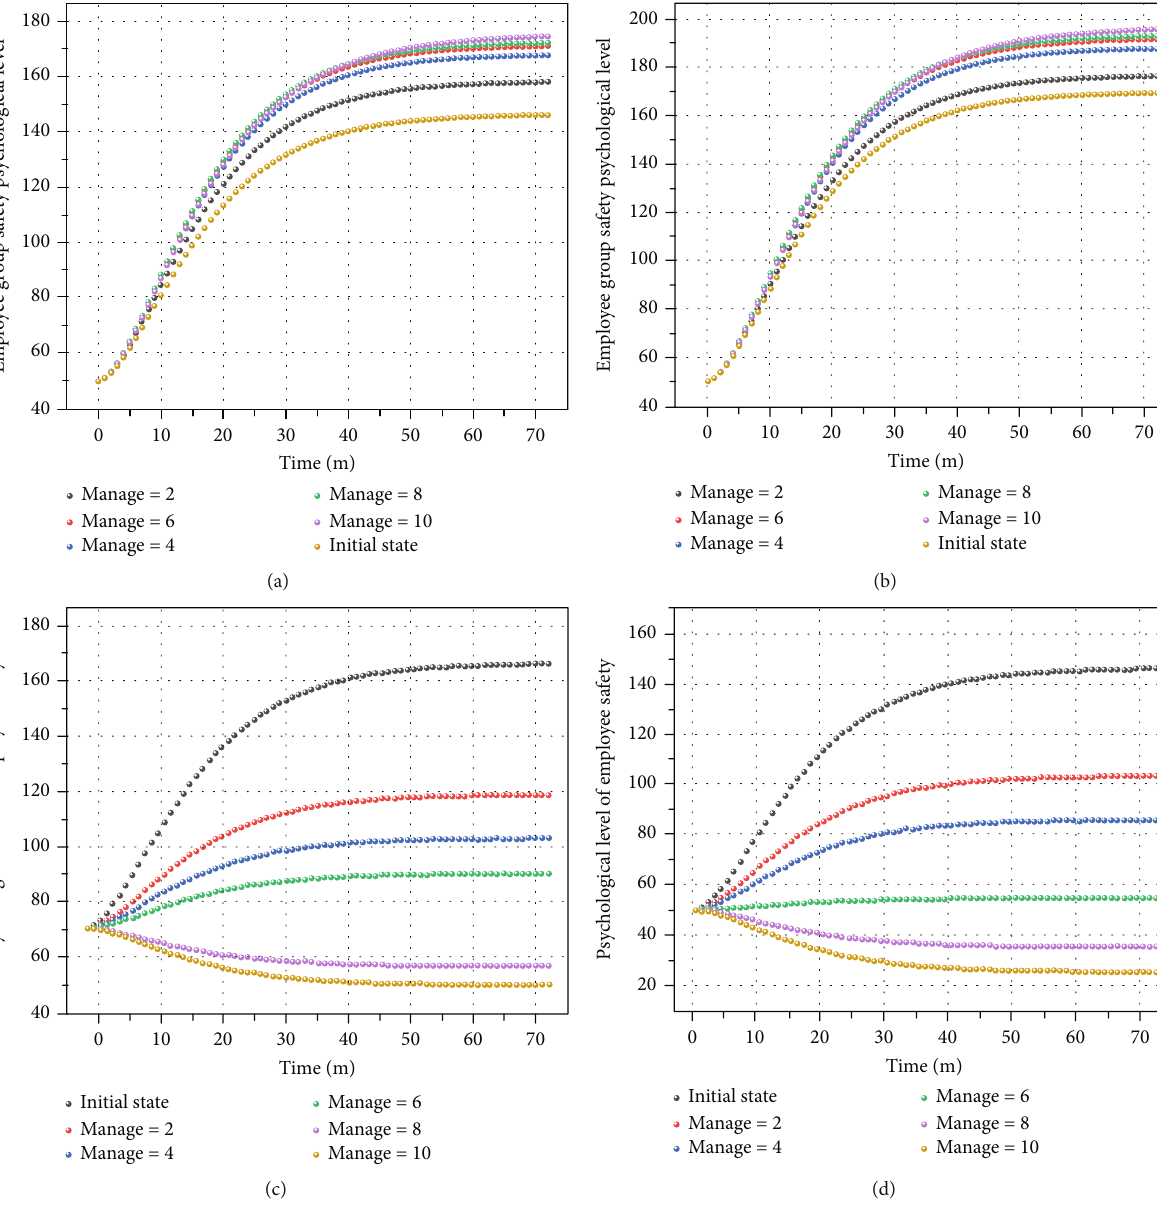
Figure 8: Evolution law of safety behavior among managers and worker groups. (a) E ff ects of management decisions on group behavior. (b) Impact of management decisions on group psychology. (c) E ff ect of external interference on group behavior. (d) E ff ect of external interference on group psychology. Table 5: Simulation scheme